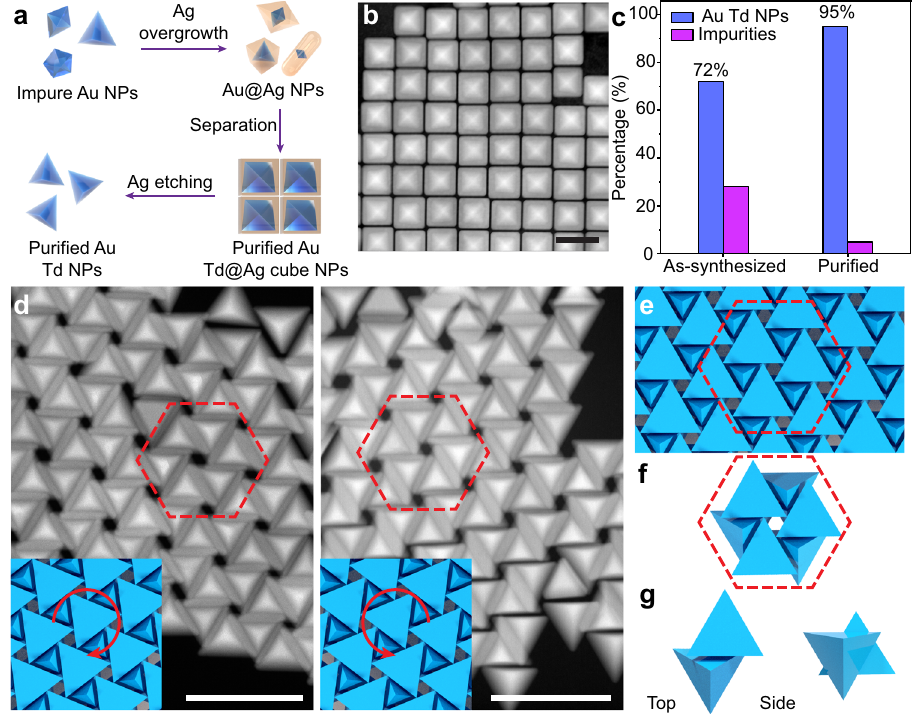
Fig. 1 Puri fi cation and assembly of Au tetrahedra. a Schematic of puri fi cation methodology in which Ag shells are grown around as-synthesized samples containing a mixture of particle shapes. Small differences in the internal twinning of Au cores are accentuated in Ag shells, allowing for selective precipitation and separation of a desired morphology, e.g. tetrahedra (Td). b Puri fi ed Au Td@Ag cube particles. c Analysis of the distribution of nanoparticle shape products from as-synthesized ( n = 7,612) and puri fi ed samples ( n = 10,259). d Left and right-handed planar chiral hexagonal superlattices of tetrahedra with insets indicating orientation. e Schematic of the 2D chiral hexagonal phase, f hexagonal repeat unit, and g top and side views of Td dimers that constitute the structure. Scale bars: b 50 nm; d 100